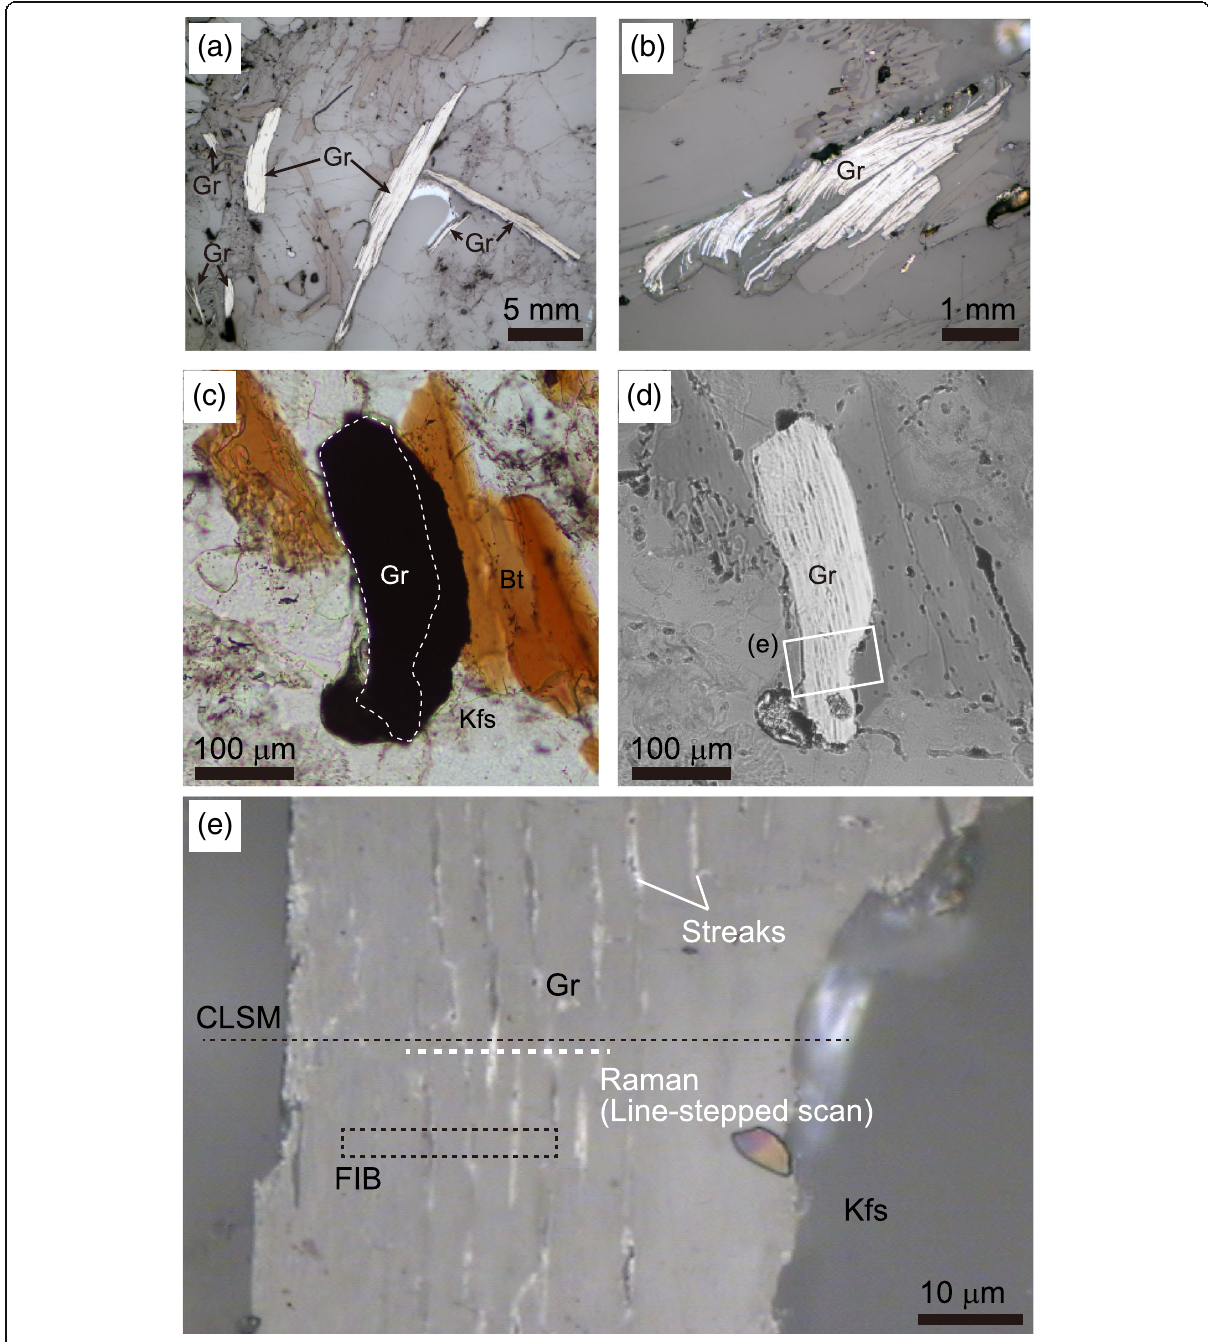
Fig. 1 Photomicrograph of the analyzed graphite. a , b Graphite grains under reflected light. c Studied graphite grain under transmitted light. The area exposed on the surface of graphite is surrounded by a white dotted line. Minerals surrounding the graphite are biotite and K-feldspar. d Studied graphite grain under reflected light. The area shown in ( e ) is indicated by a white square. e Magnified reflective microscope image of studied graphite. Streaks (grooves) extending in one direction can be seen on the graphite surface. The black dashed line and white dashed line indicate the place where the CLSM and the line-stepped scan by Raman spectroscopy were preformed, respectively. The area cut out using the FIB is enclosed by a black square. Abbreviations are Bt, biotite; Gr, graphite; Kfs,